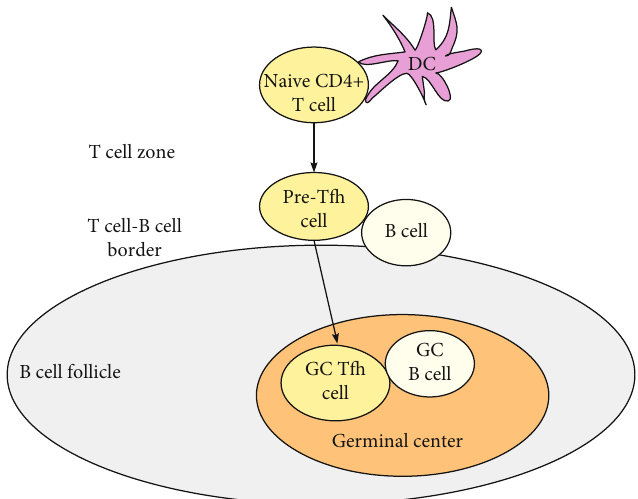
Figure 1: The di ff erentiation of Tfh cells. Naive CD4 + T cells are primed by MHC/antigen interaction with DCs and di ff erentiate to pre-Tfh cells; then, pre-Tfh cells migrate to the T-B border and interact with cognate B cells; fi nally, interactions between pre-Tfh cells and B cells lead to the formation of GC Tfh